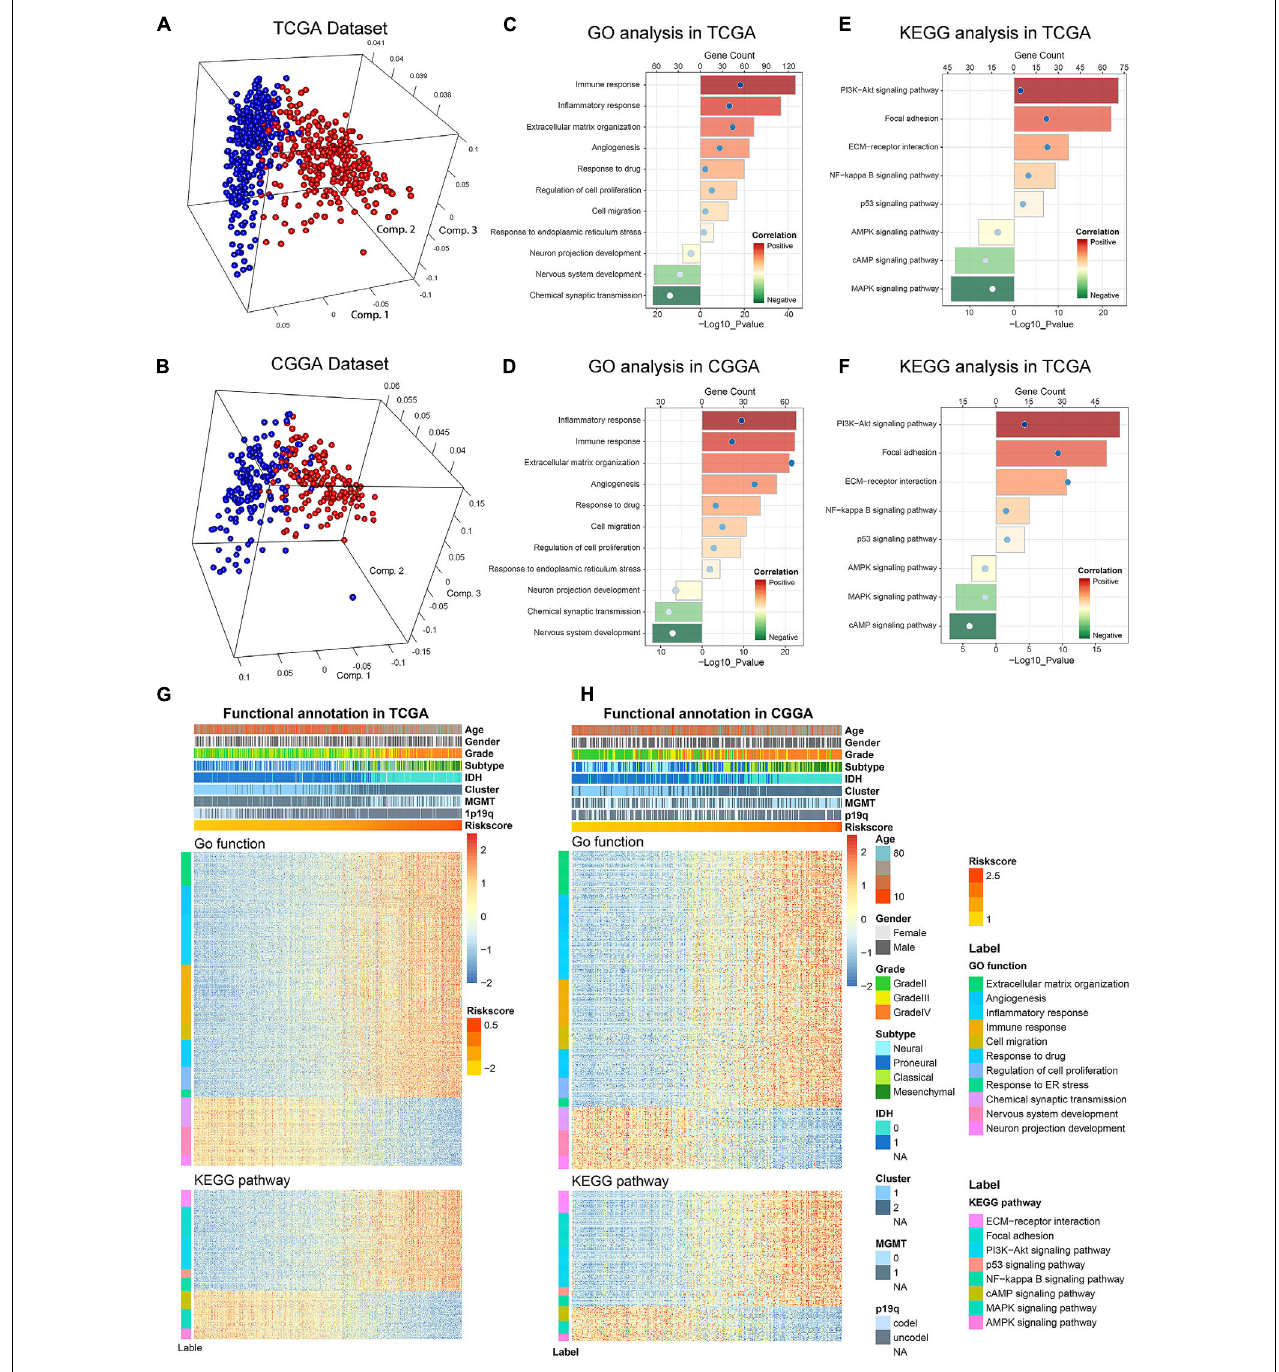
FIGURE 5 | Biological functions and pathways analyses of the ER stress-related signature in TCGA and CGGA datasets. (A,B) There is a significant separation between high-risk and low-risk groups in PCA analysis based on whole gene expression data. (C,D) GO analyses were performed to explore the biological processes tightly related to the risk signature. (E,F) KEGG pathway analyses were performed to explore the signaling pathways tightly related to the risk signature. (G,H) The heatmaps showed the association among risk score, clinicopathological features and ER stress-related biological functions and pathways.